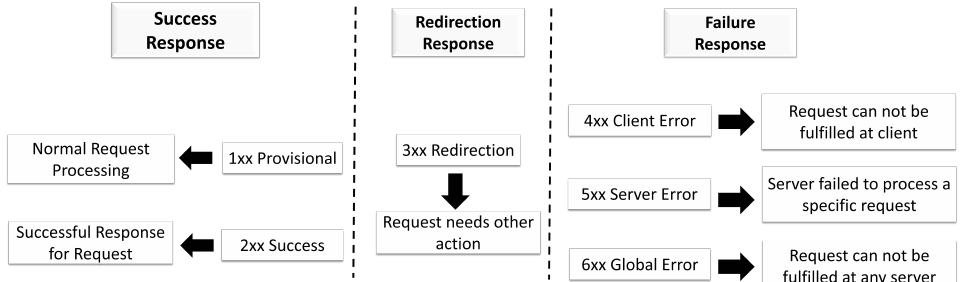
Figure 6. SIP responses